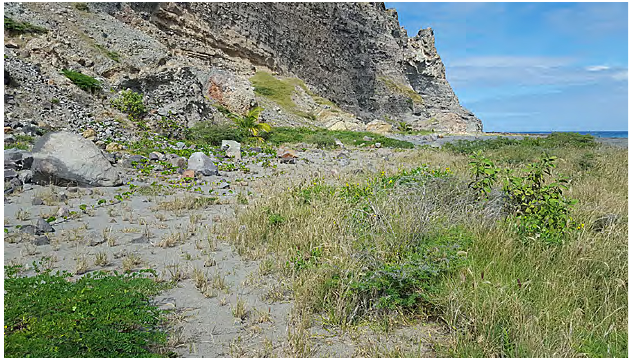
Figure 2. Beach habitat south of Bottomless Ghaut where Gymnophthal- mus underwoodi specimens were